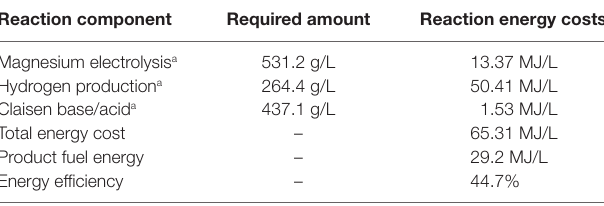
TaBle 3 | Minimum energy cost per liter of butanol fuel produced from CO 2 and hydrogen